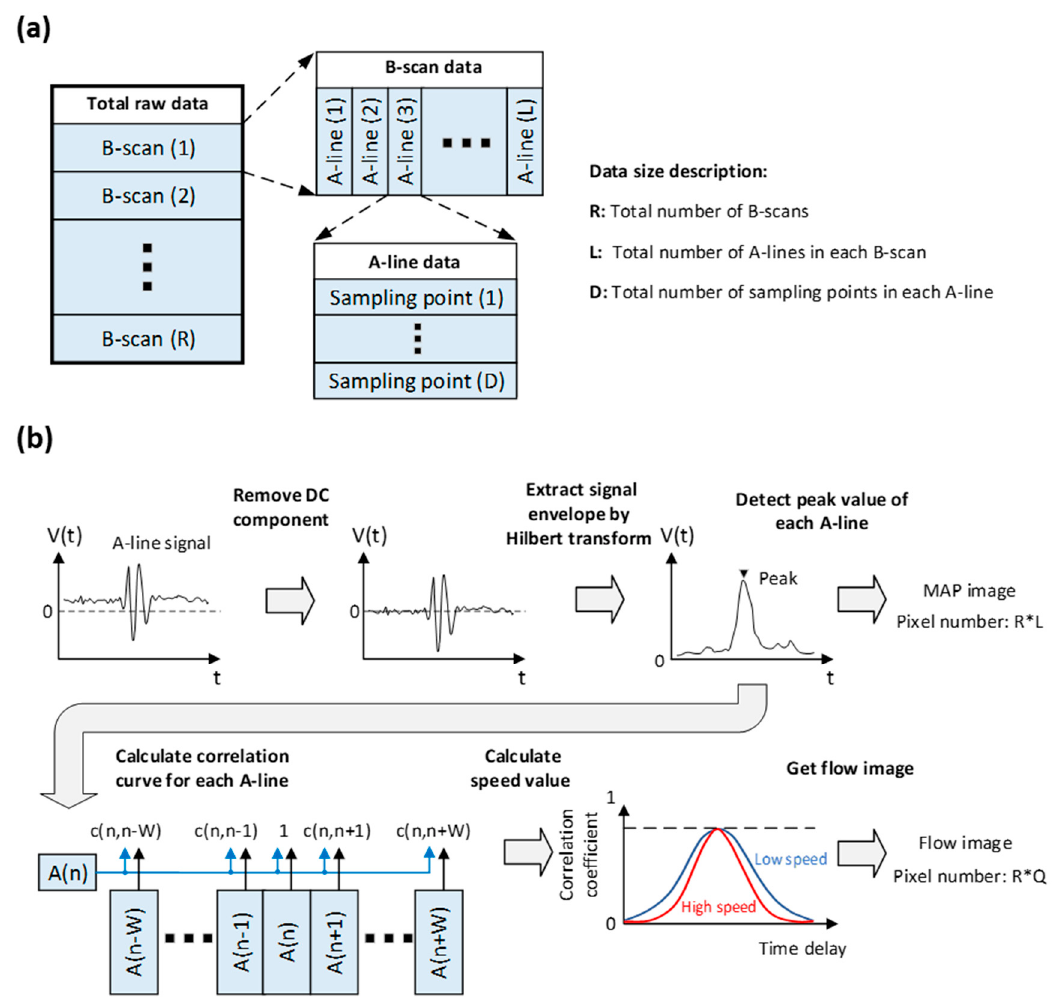
Figure 3. ( a ) Raw data format. ( b ) Flow chart for blood flow calculation.